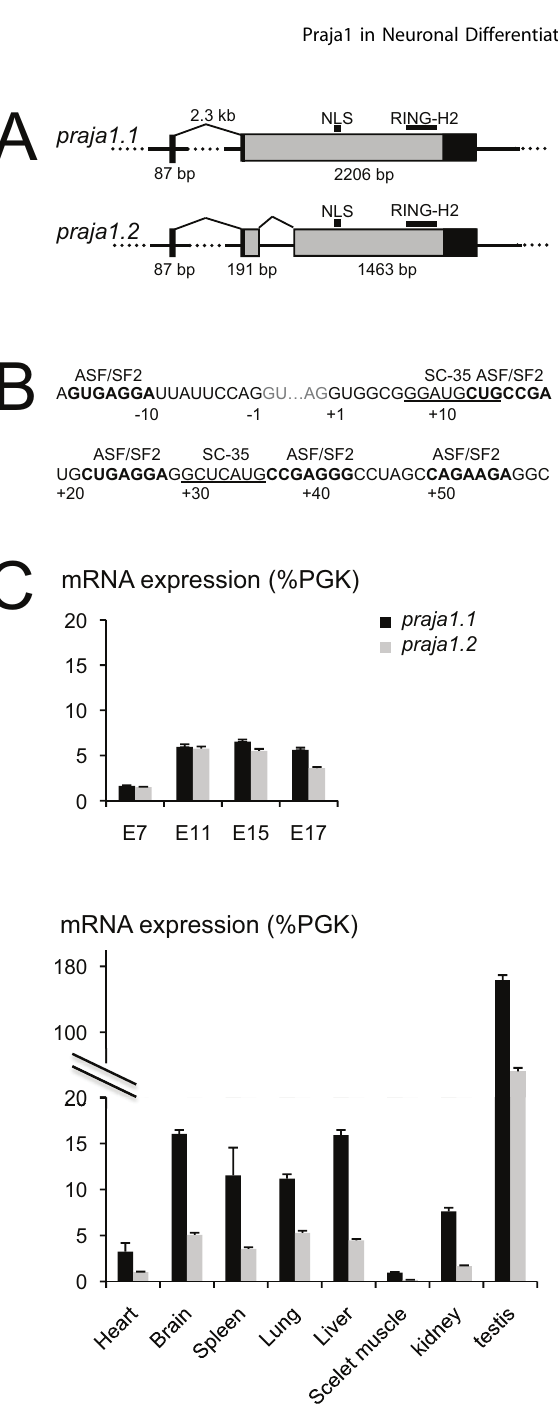
Figure 1. Expression of praja1 transcript variants. (A) Two splice variants are generated from the PJA1 gene through an intron retention mechanism. Constitutive splicing of intron 1 and alternative splicing of exon 2 utilize canonical splice sites. Squares: mRNA sequence. Light grey squares: coding sequence. NLS: nuclear localization signal. Ring- H2: Ring-H2 ring finger motif. (B) Sequences surrounding splice sites in praja1 variants and associated exonic splice enhancer motifs. Prominent SC-35 binding motifs could be identified in addition to ASF/SF2 sites. (C) Praja1 mRNA expression is readily detectable by embryonic day E7, with a 1:1 ratio of transcript variants praja1.1 and praja1.2 . In the adult mouse praja1 mRNA expression is highest in testis, followed by brain, liver, lung, and spleen. The variants are expressed in a ratio between 2:1 and 5:1 in all tissues investigated (3:1 in brain). Values are relative to the housekeeping gene phospho-glycerate kinase